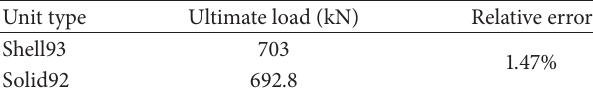
Table 2: The influence of unit type on bearing capacity.